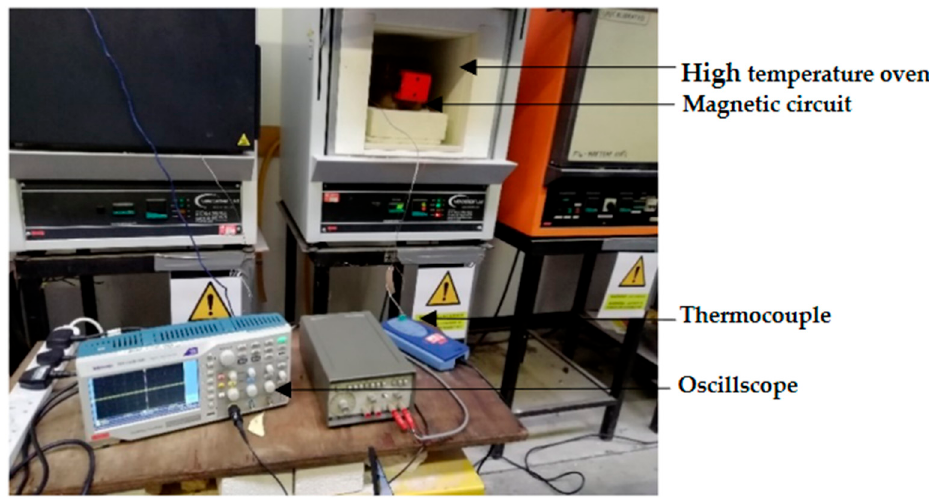
Figure 6. Measurement setup for high temperature testing.